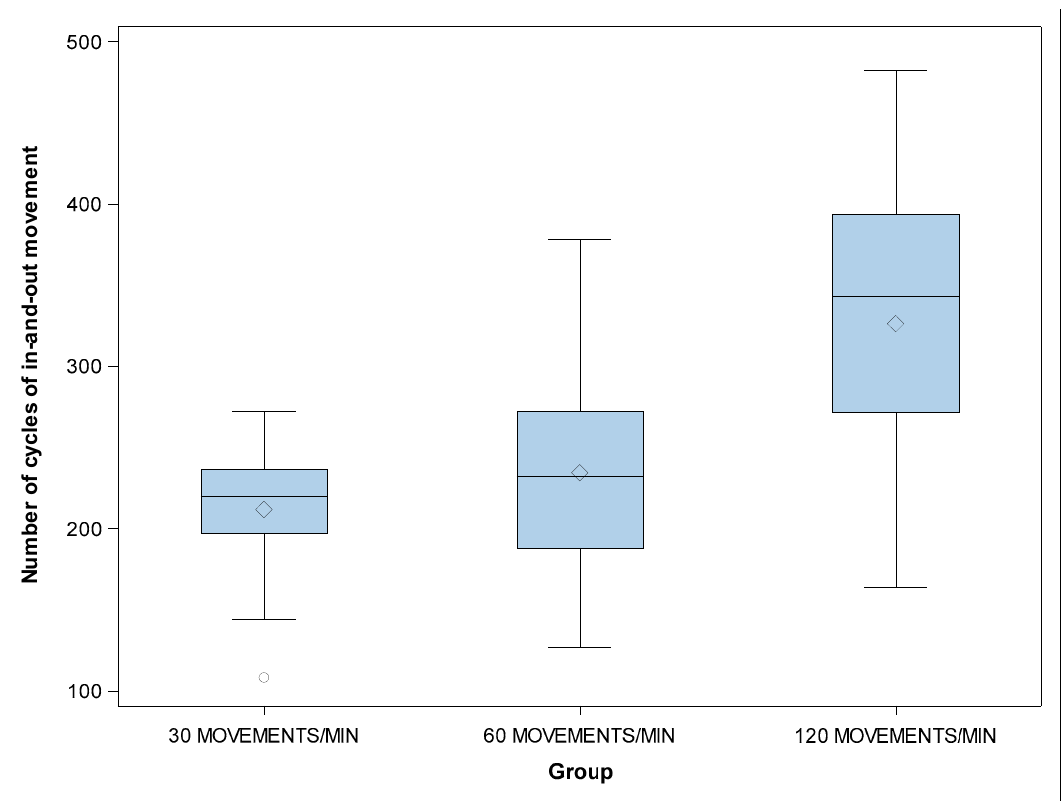
Figure 7. Weibull probability plot of the NCF.